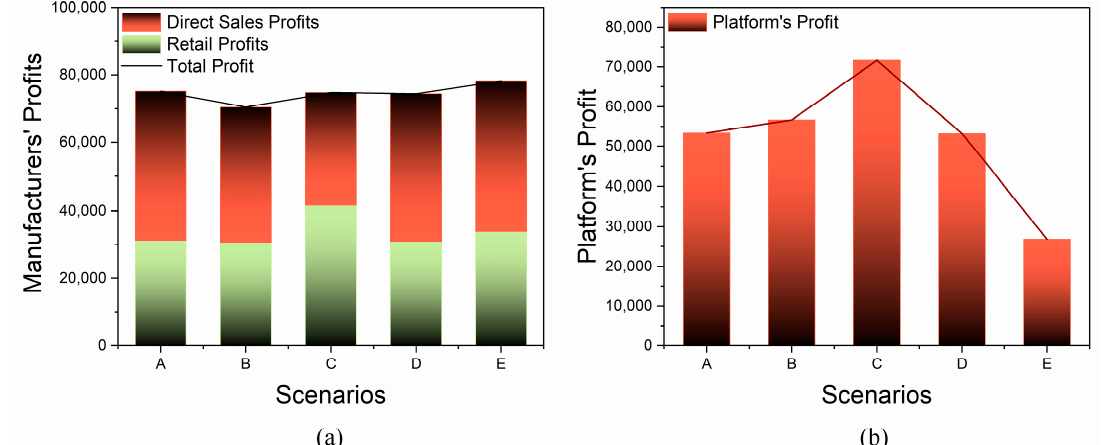
Figure 17. The profits of: ( a ) manufacturers; ( b ) the e-commerce platform. ( t =